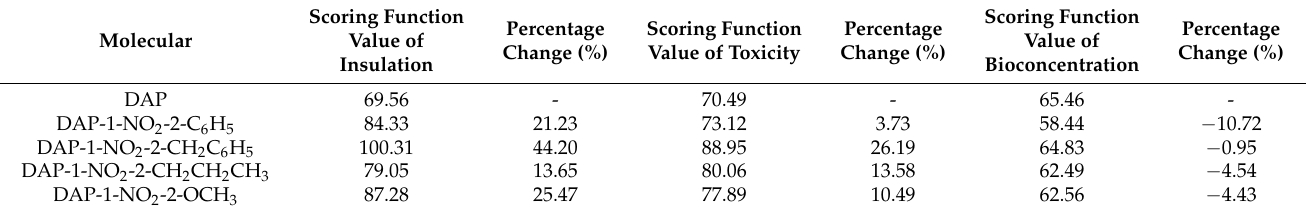
Table 5. Scoring function value and percentage change of PAE derivatives based on DS software. Scoring Function Molecular Value